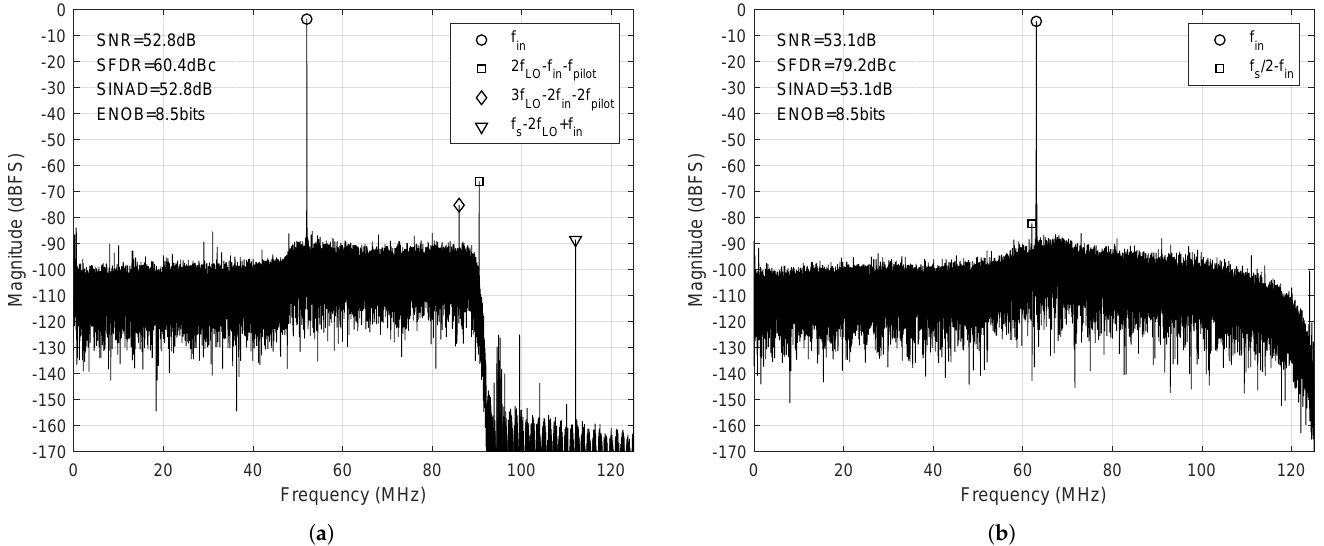
Figure 15. Single tone test spectrum near diplexer common frequency: ( a ) 52 MHz input signal for classical; ( b ) 63 MHz input signal for synchronous